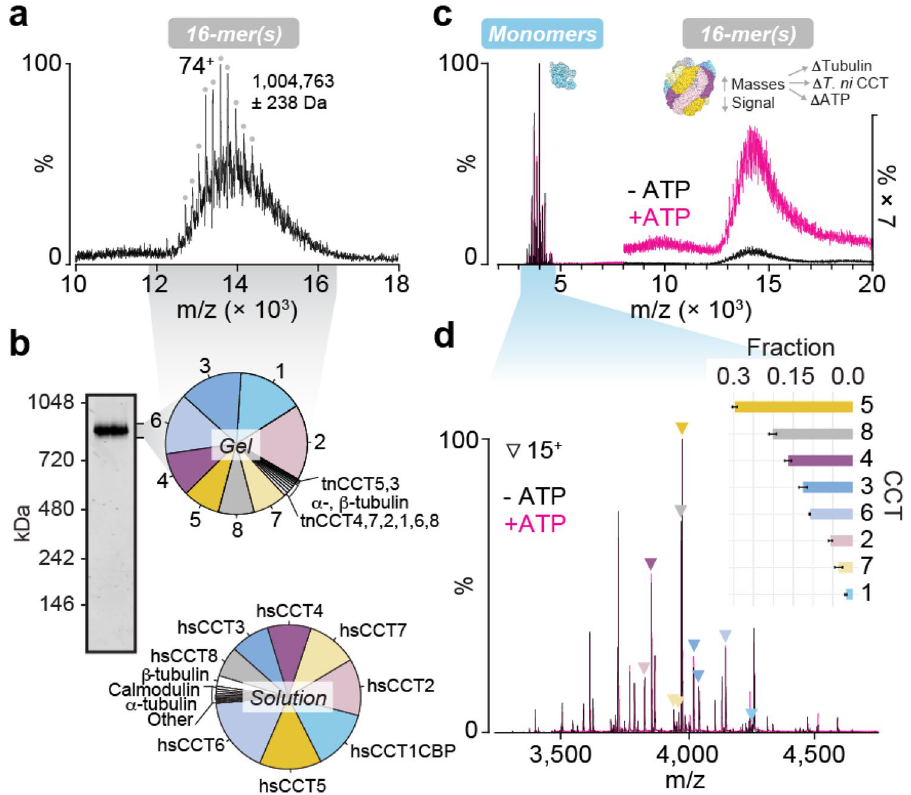
Figure 2. The hTRiC holocomplex is heterogeneous in mass and stabilized by ATP. ( a ) High m/z region of a native mass spectrum of TRiC, with optimal transmission of the complex. The labelled mass, calculated using the charge series designated by gray circles, corresponds closely to a 16-mer associated with tubulin and ATP. ( b ) Proteomic analysis of hTRiC solution (bottom) and the hTRiC complex excised as a band from NativePAGE (top). Pie charts show filtered hits in order of relative abundances estimated by label-free intensity-based quantification. ( c ) Complete native mass spectra of hTRiC before and after addition of ATP, with instrument conditions favoring transmission of the monomers. Signal to noise of the 16-mer is low, but improves upon addition of ATP, indicating stabilization or mass coalescence. ( d ) Detailed view of the regions of native MS in c containing dissociated CCT subunits. Triangles indicate each 15 + charge state. The inset bar graph shows each subunit’s fractional abundance relative to all measured monomers; i.e., CCT5 comprised 30% of all monomer signal. More abundant subunits are more stable after dissociating from the 16-mer, remaining folded for the duration of the experiment. Bars show the average and SD between + /− 500 µM ATP (black and pink mass spectra) to emphasize that addition of ATP, while it stabilized the complex, did not affect the relative abundances of detected